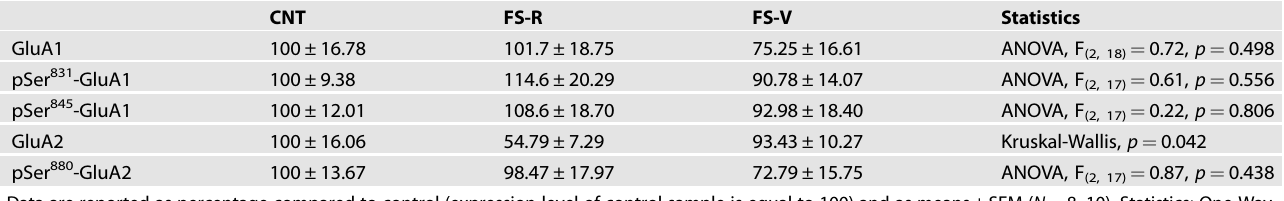
Table 2. Protein expression and phosphorylation of AMPA receptor subunits in PFC synaptic